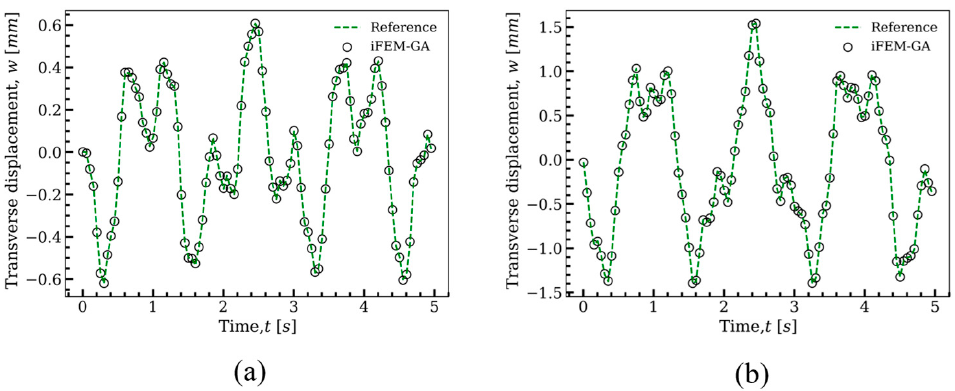
Figure 9. Time history of the transverse displacement of the plate depicted in Figure 4 under the load of F = − 2cos ( ω p t ) − sin ( ω p t ) N, with ω p = 10.52 rad/s. A comparison of the reference solution and